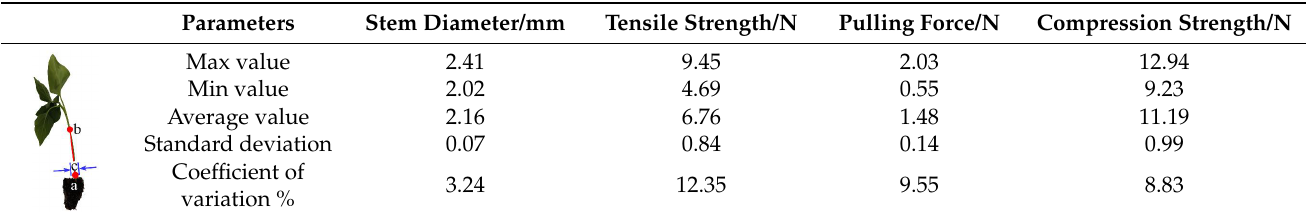
Table 1. Biological and mechanical differences between pepper seedlings.